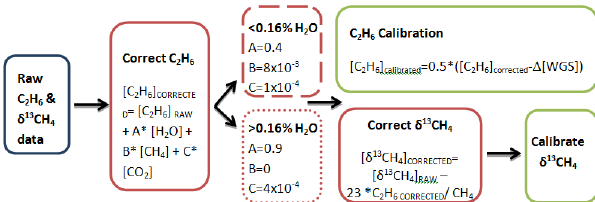
Figure 12. Flow chart illustrating the steps and the correspond- ing equations to calibrate C 2 H 6 and δ 13 CH 4 as determined from this study. The coefficients are the mean of both CRDS instruments tested. We suggest removing H 2 O from gas samples prior to analy-